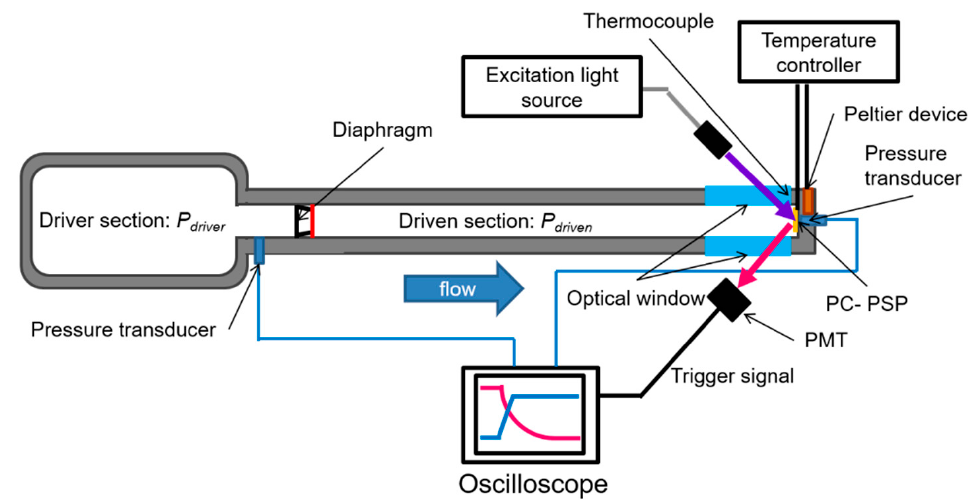
Figure 3. Schematic of dynamic characterization setup.